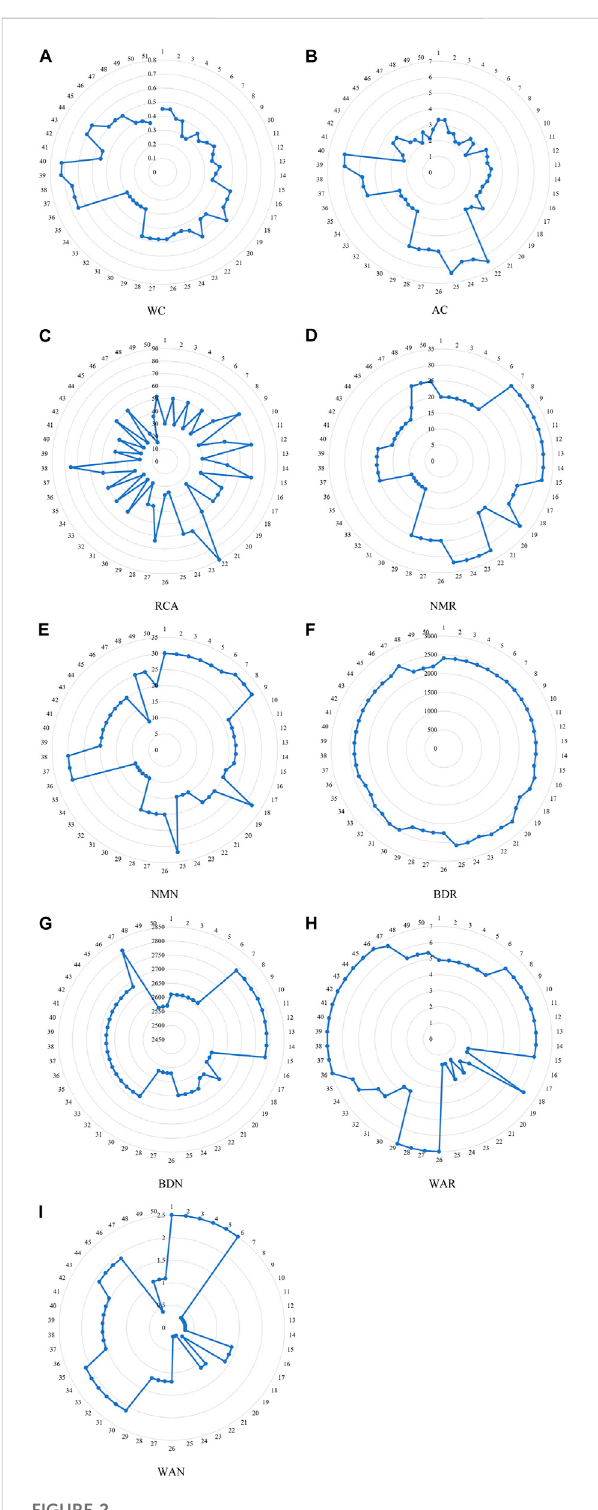
FIGURE 2 The datadistributionofinputvariables[ (A) :WC, (B) :AC, (C) :RCA, (D) : NMR, (E) : NMN, (F) : BDR, (G) : BDN, (H) : WAR, (I) :